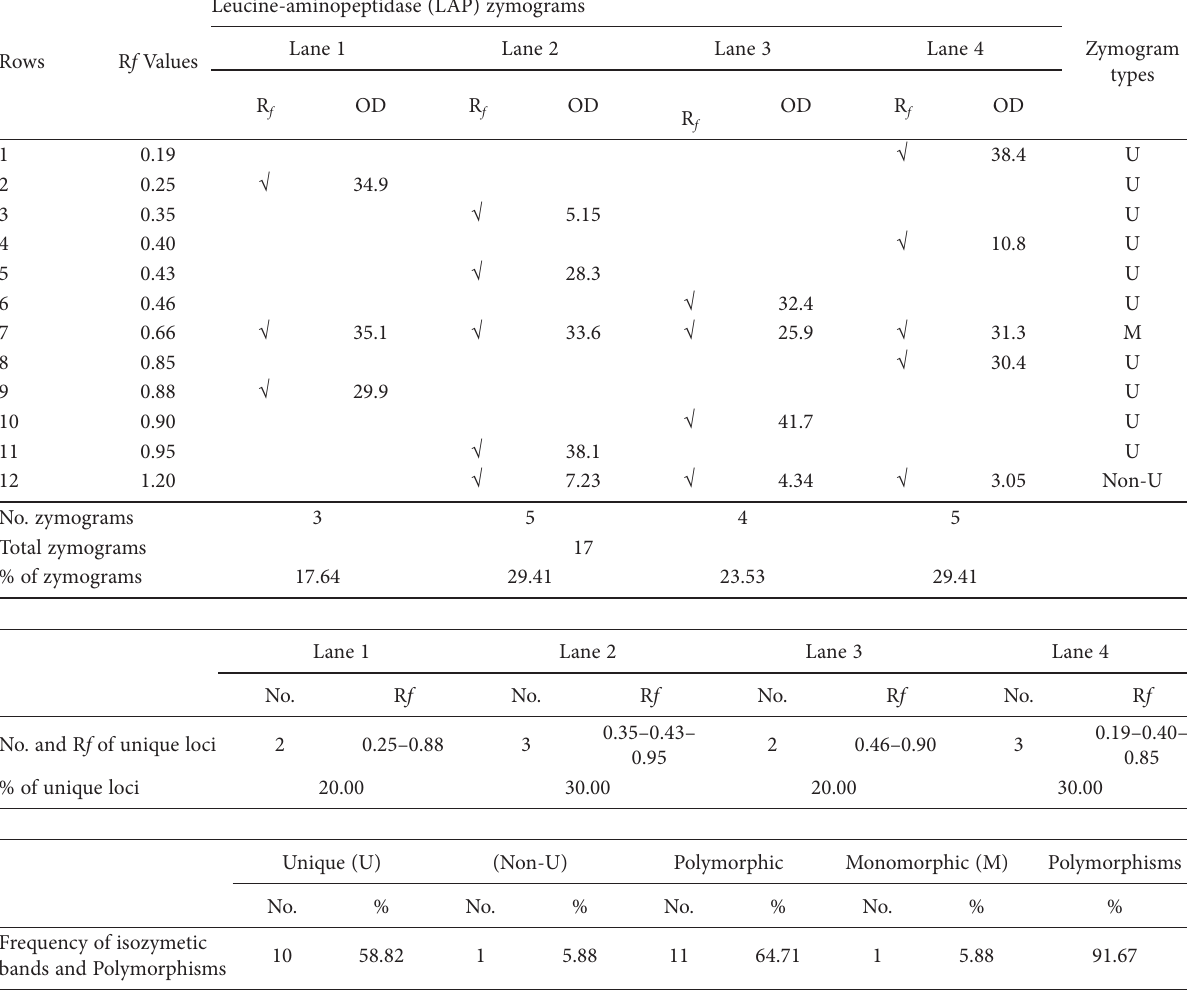
Table 2. Distribution of leucine-aminopeptidase (LAP) zymograms of EMF non-exposed and exposed Zea mays seedlings for days of expo- sure times (Ex-0, Ex-1, Ex-3, and Ex-5) based on relative front (R f ) Values and optical densities (OD). Lanes 1–4 represented the days of exposure times (Ex-0, Ex-1, Ex- 3, and Ex-5),